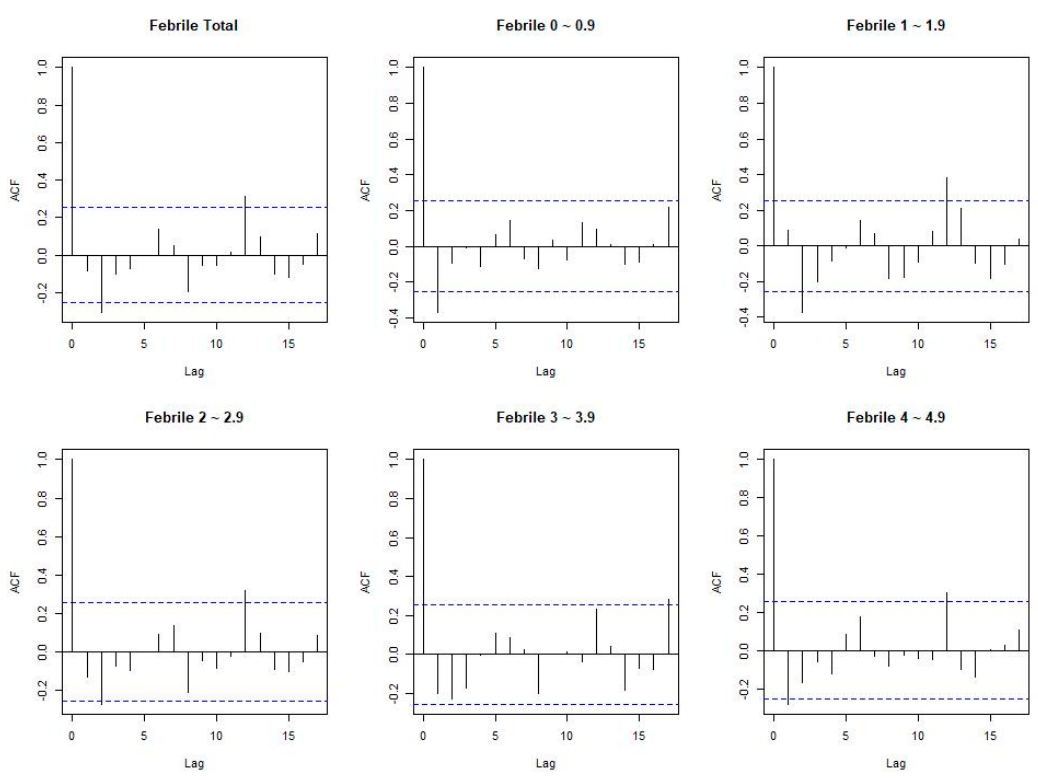
Figure 2. The autocorrelation function (ACF) is a statistical technique to determine the degree of correlation between the values in a time series. ACF after differencing. Table 1. Parameters of ARIMA models for febrile convulsion patients by age.